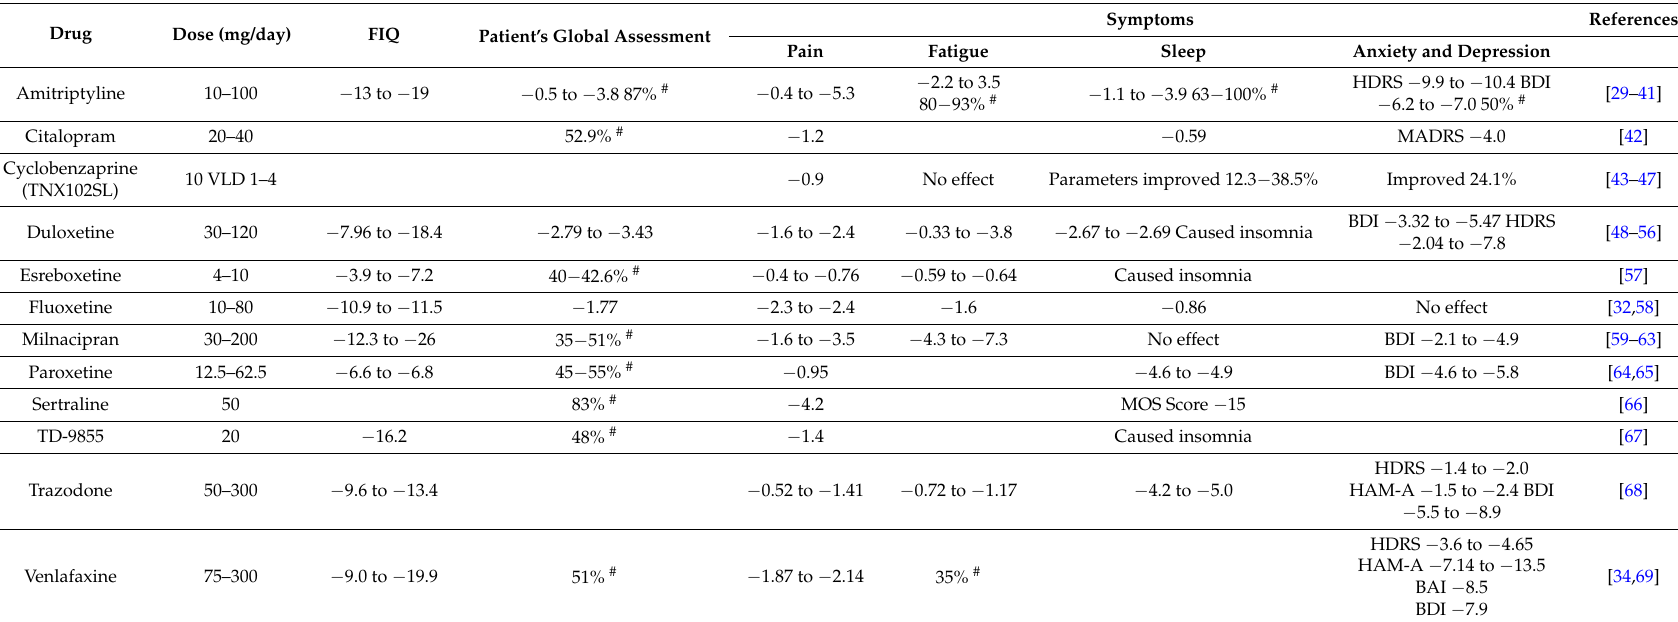
Table 2. Efficacy of antidepressant drugs in the treatment of fibromyalgia. Data are presented based on the effects of antidepressant drugs on the Fibromyalgia Impact Questionnaire (FIQ), Patient’s Global Impression Assessment and primary symptoms. Changes in score ratings are presented on a 0 to 10 scale, except FIQ (0–100), Hamilton Rating Scale for Depression (HDRS), Hamilton Anxiety Rating Scale (HAM-A; 0–56), Beck Depression Inventory (BDI; 0–63), Beck Anxiety Inventory (BAI; 0–63), and Montgomery–Åsberg Depression Rating Scale (MADRS; 0–60). The proportion (%) of patient population gaining significant benefit for a domain, where available, is indicated by # . MOS = Sleep Scale from the Medical Outcomes Study; VLD = very low dose. Dose (mg/day)